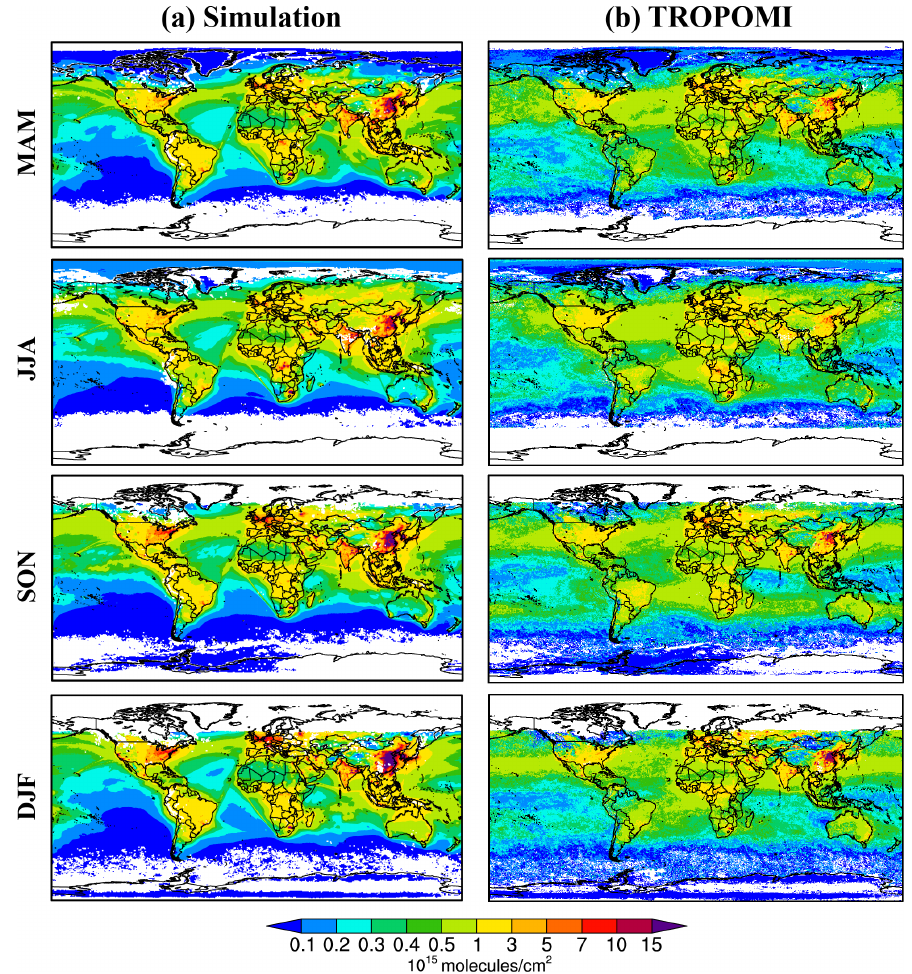
Figure 4. Spatial distributions of seasonal mean NO 2 columns from (a) GNAQPMS averaged in 2018 and (b) the TROPOMI